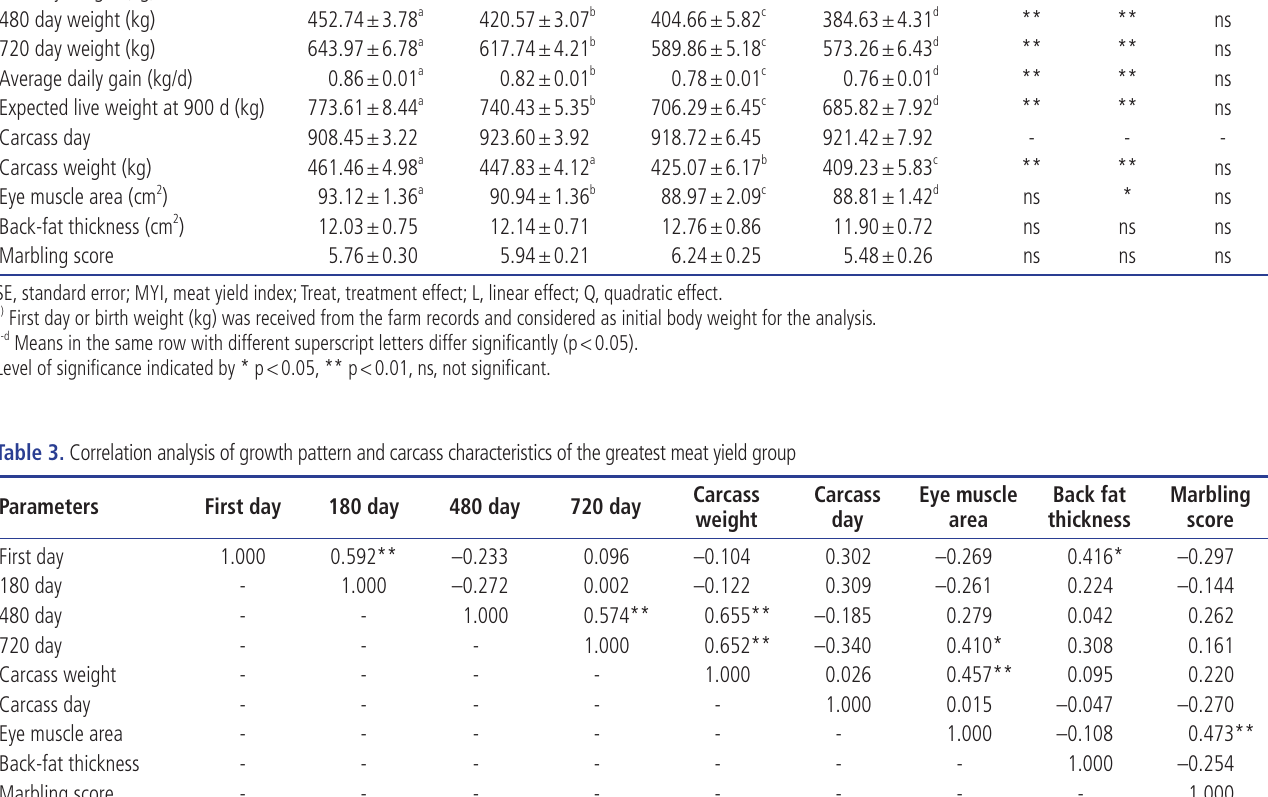
Table 2. Body weight change by growth stage and carcass characteristics of Hanwoo steers (mean±SE) as influenced by meat yield Parameters